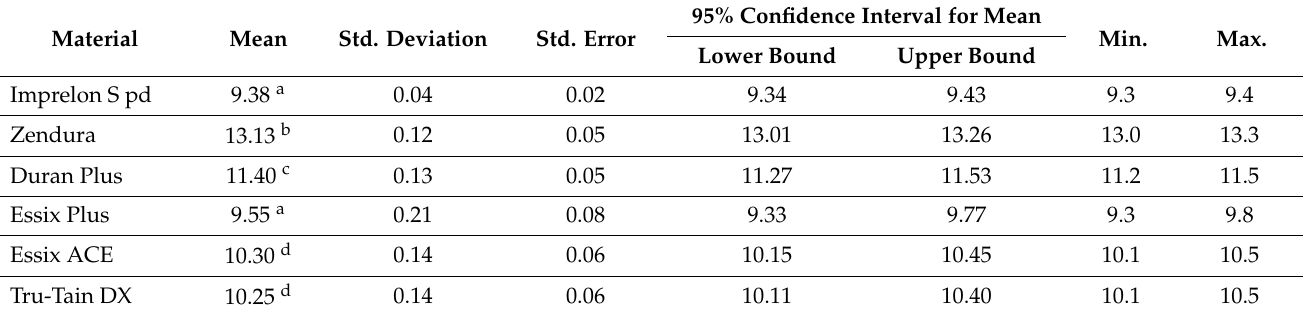
Table 6. Descriptive analysis of hardness values of Group 2 (the same small letter indicates no significant difference between the materials at p < 0.05